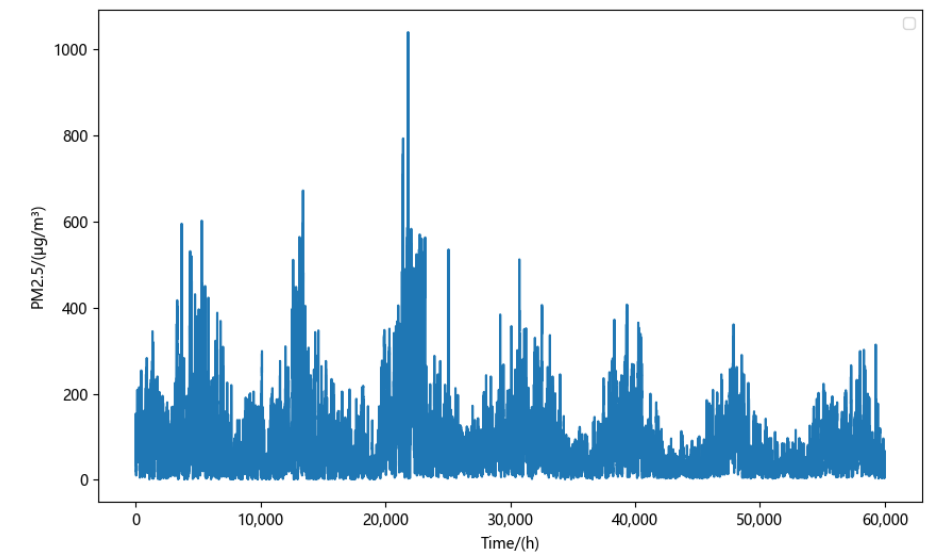
Figure 3. Changes in PM2.5 concentration over